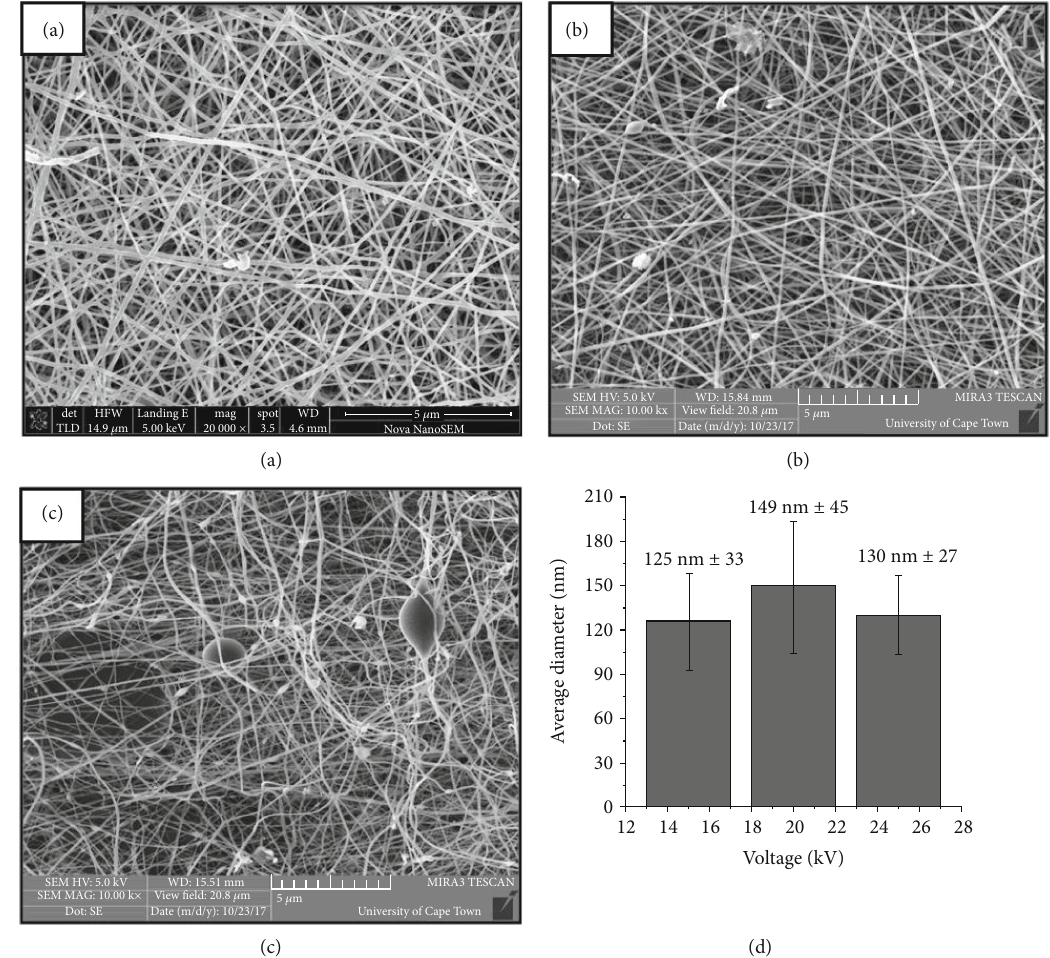
Figure 6: SEM images and average fi ber distribution of the 30/70 CS/PVA blend at di ff erent voltages of (a) 15 kV, (b) 20 kV, and (c) 25kV with a spinning distance of